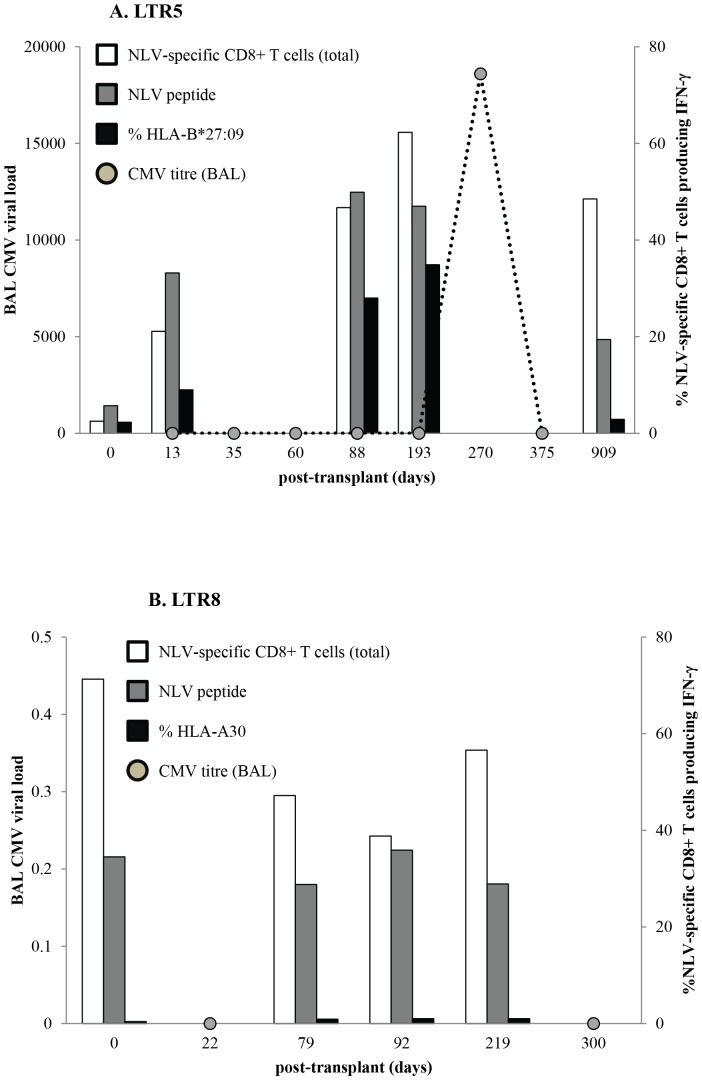
Presence of CMV reactivation increases magnitude of cross-reactivity against the allograft.Comparison of CMV viral load in the BAL (grey circles, left y-axis) and NLV-specific cross-reactivity responses towards B27 and A30 (6 hour ICS assay using day 13 T cells) were measured against time after lung transplant in LTR5 (top) and LTR8 (bottom), respectively. A CMV reactivation episode was classified for viral titres above 10,000. LTR5 experienced CMV reactivation at day 270 post-transplant but had ceased after day 375. A steady increase in B*27:09-cross-reactivity response based on %IFN-γ production of tetramer+CD8+ gated cells (black bars, right y-axis) and %tetramer+CD8+ cells of total CD8+ T cells (white bars, right y-axis) were observed prior to CMV reactivation event at day 193 but had dropped to pre-transplant levels after CMV reactivation had ceased. For LTR8, BAL CMV viral titre was not detected post-transplant. In alignment, A30 cross-reactivity and %tetramer+CD8+ cells of total CD8+ T cells remained consistent post-transplant.